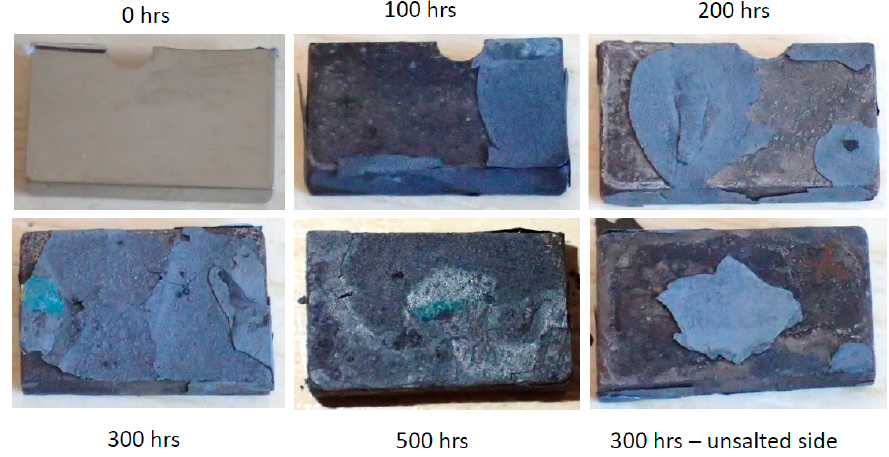
Figure 5. Macrographs showing visual appearance of aggressive attack and spallation for corroded Rene ′ N5 as a function of time.